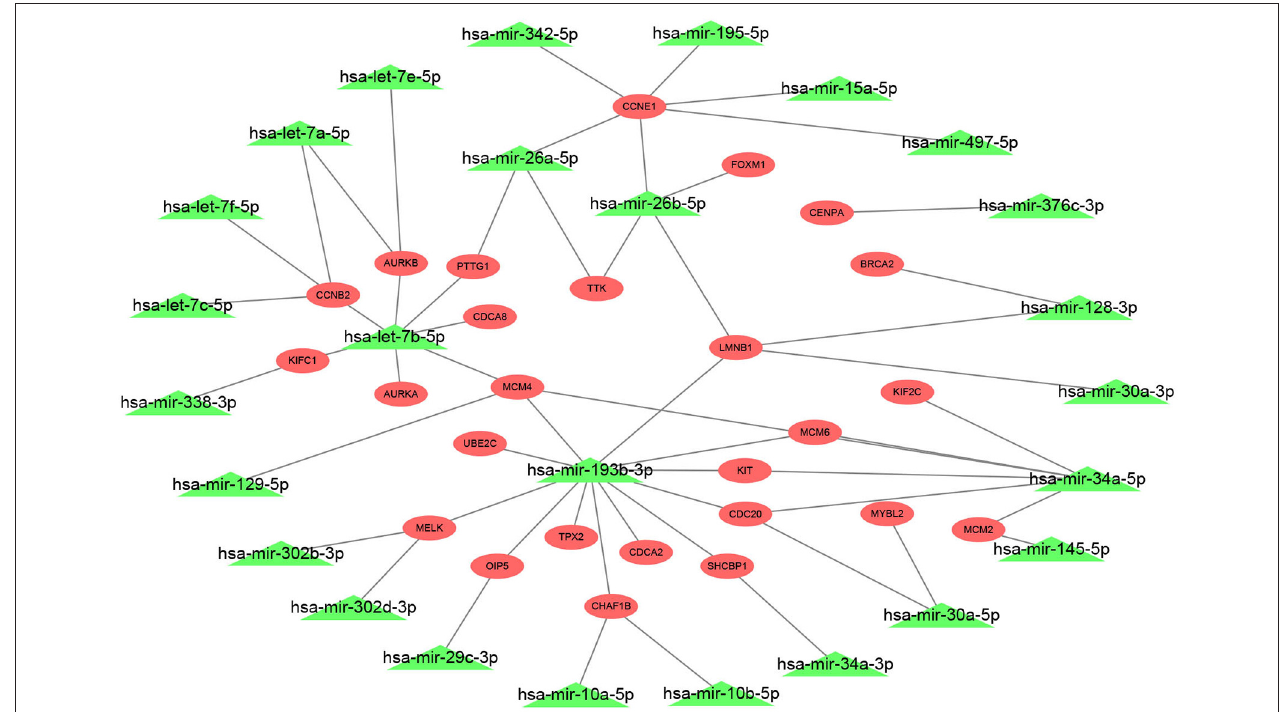
FIGURE 4 | Construction of a potential miRNA-mRNA regulatory network in ER α positive breast cancer. The genes in red ellipse represented that they were significantly upregulated in luminal B breast cancer compared with luminal A breast cancer; the miRNAs in green triangle represented that they were markedly downregulated in luminal B breast cancer compared with luminal A breast cancer.